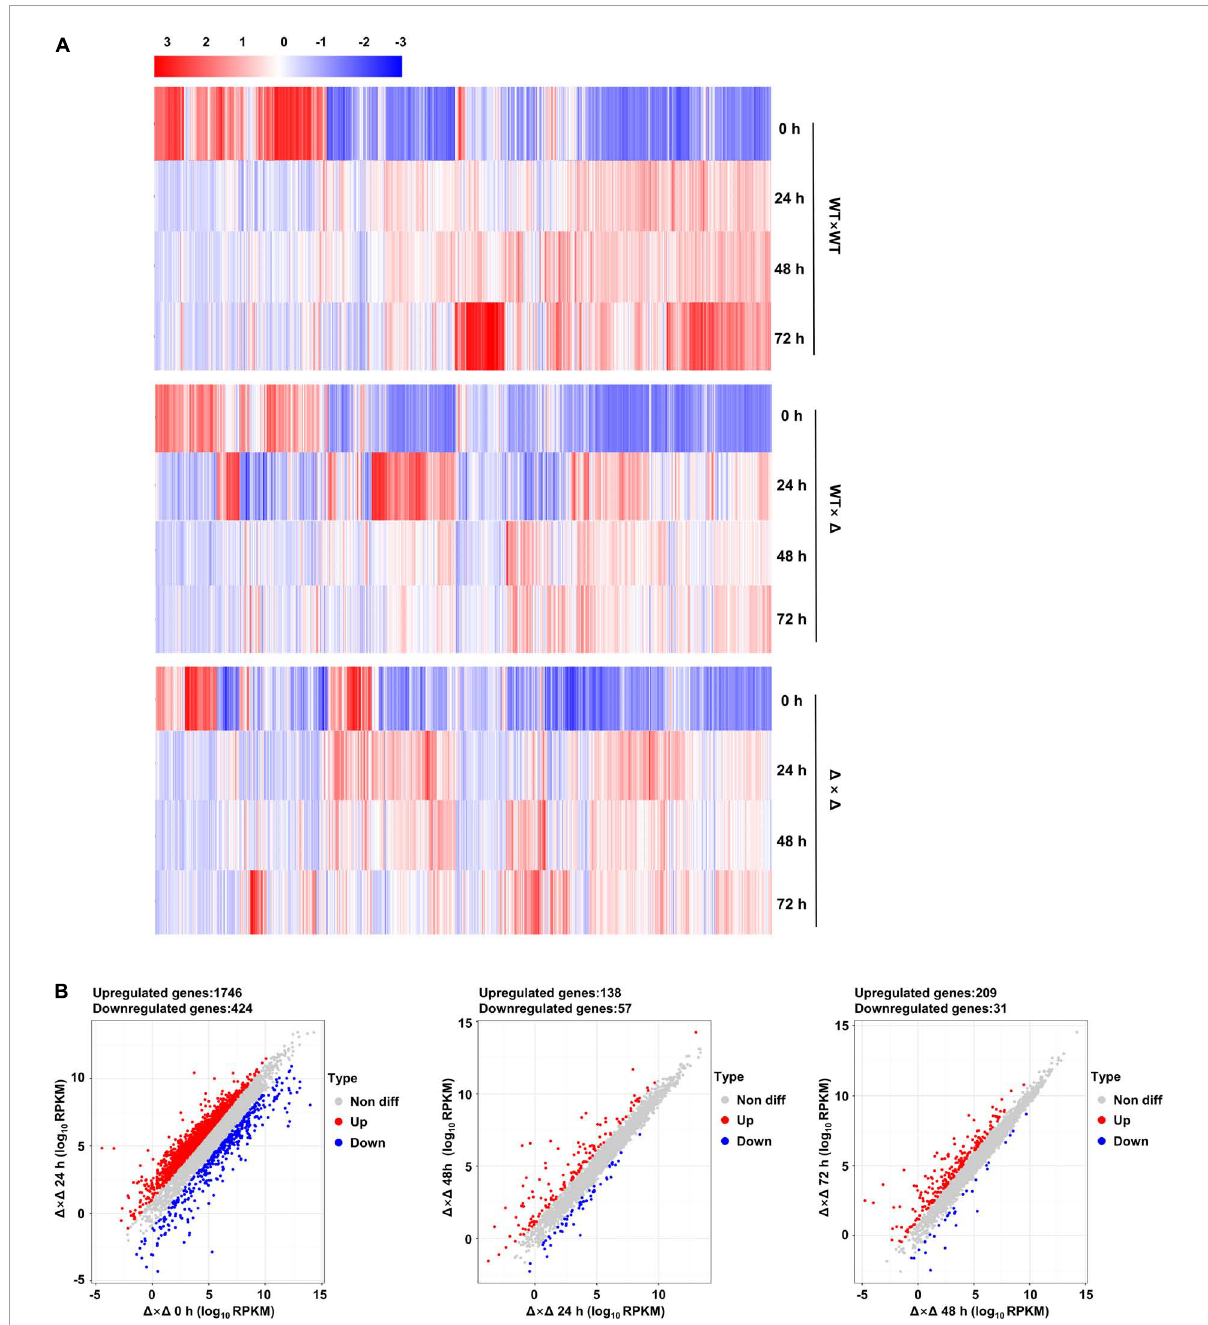
FIGURE6 Time course of transcriptional reprogramming during mating. (A) Heat maps generated on the basis of RPKM values. Red indicates high expression, and blue indicates low expression. Samples were taken at 0, 24, 48, and 72 h. (B) Scatter plots of differentially expressed genes (DEGs) of (cid:49) × (cid:49) with 0 h as a